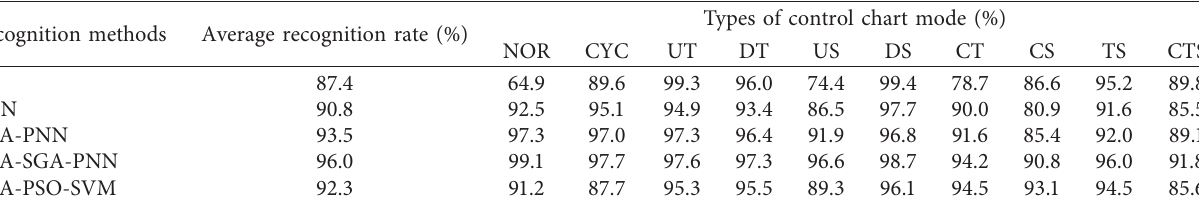
Table 3: Comparison of different methods.